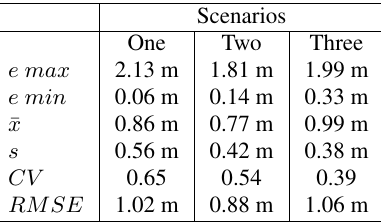
Table 4. Accurate and precise location results